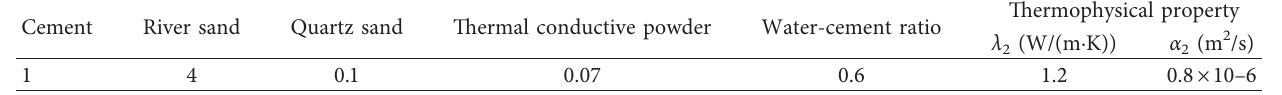
Table 1: Ratio and properties of similar material for surrounding rock [9]. Cement